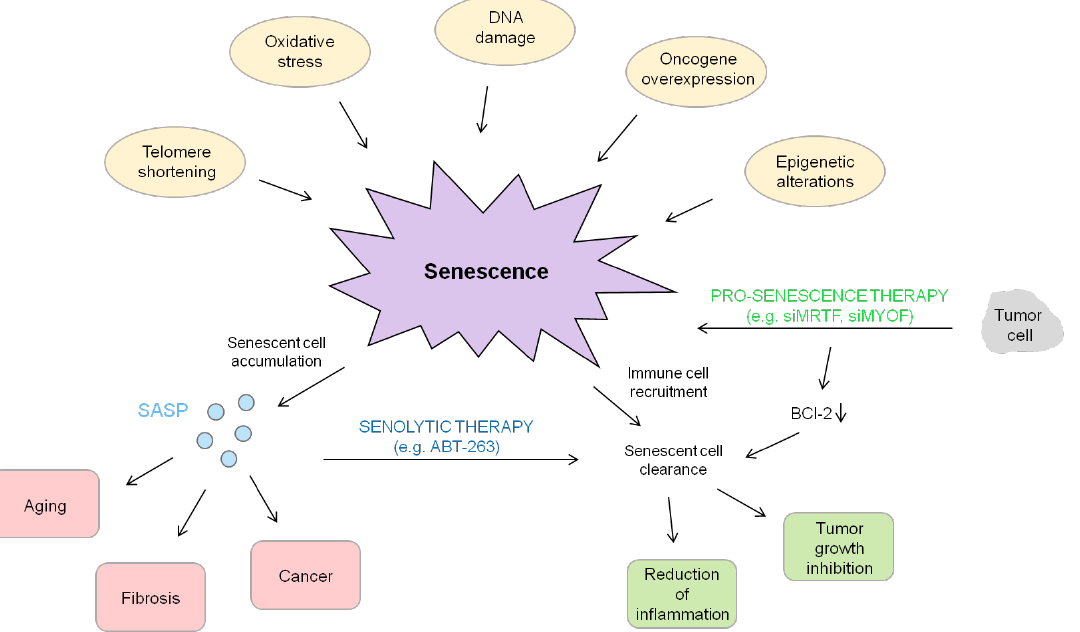
Figure 3. Summary of senescence events. Senescence is activated by a variety of different triggers, such as telomere shortening or oncogene overexpression. On the one hand, an accumulation of senescent cells and the subsequent secretion of SASP can be deleterious by resulting in aging, fibrosis and cancer. On the other hand, the induction of senescence combined with the clearance of senescent cells can be beneficial due to its tumor growth inhibition and suppression.